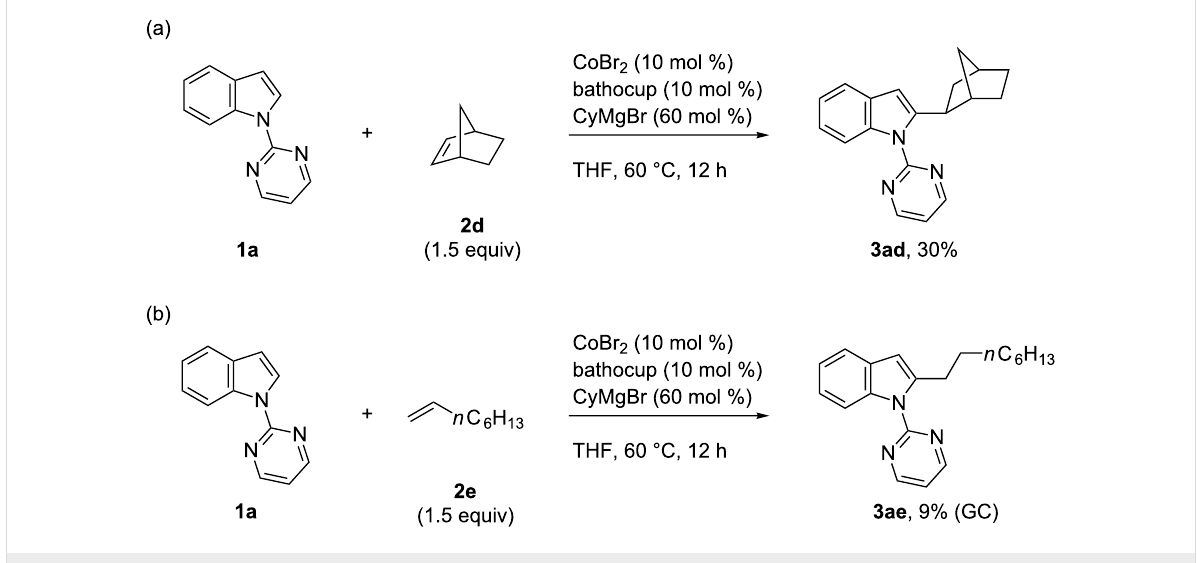
tolerance of electron-withdrawing (F and Cl) and